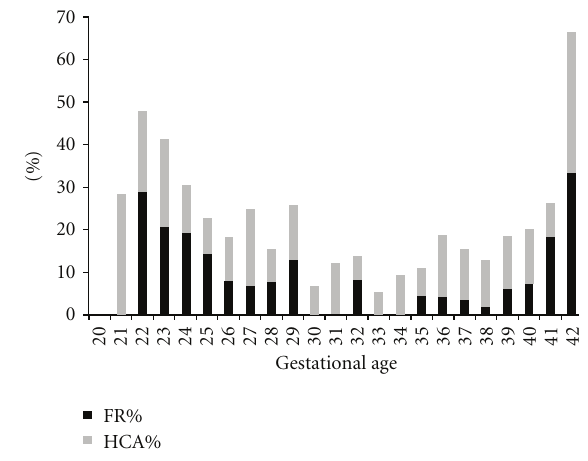
Figure 1: Histological chorioamnionitis and fetal response in stillbirths by gestational age in NSW 2002–2004 ( N =